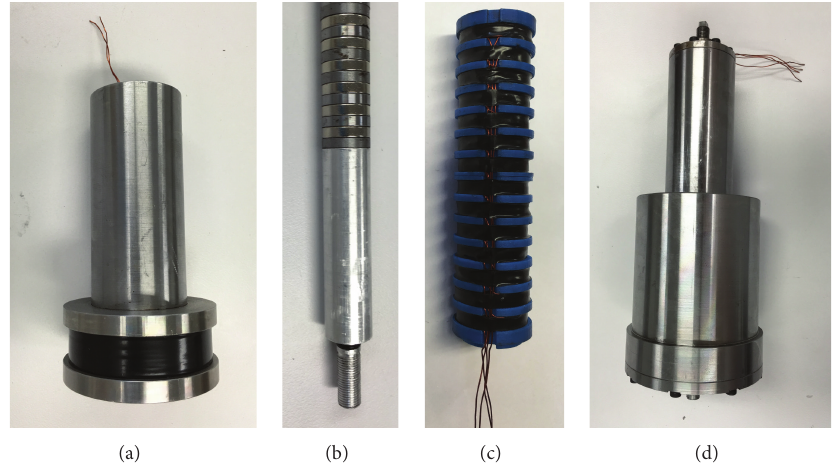
Figure 10: The proposed MR damper: (a) piston head, (b) permanent magnets array and shaft, (c) winding base and inducing coils of generator, and (d) the assembly.